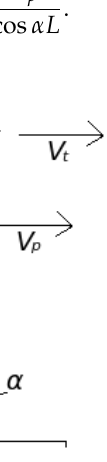
Figure 7. Model of leg and